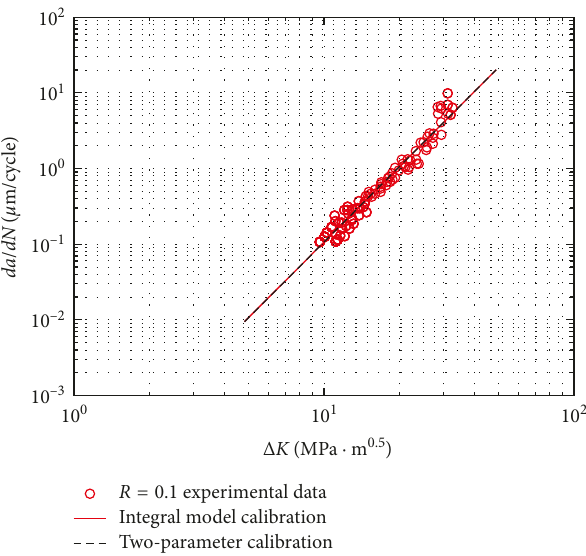
Figure 7: da / dN - K calibration of Al 7075-T6. Δ Table 3: The crack increments in the whole loading path. The loading path The integral model The traditional two-parameter